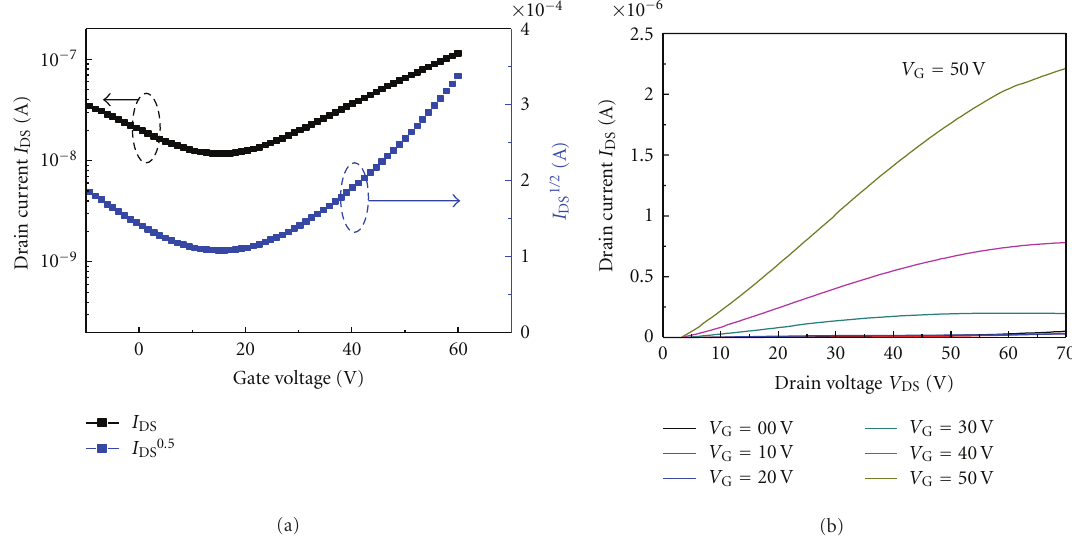
Figure 10: Transfer and output characteristic of ZnO-based TFTs fabricated using inkjet-printed active channel and gate dielectric